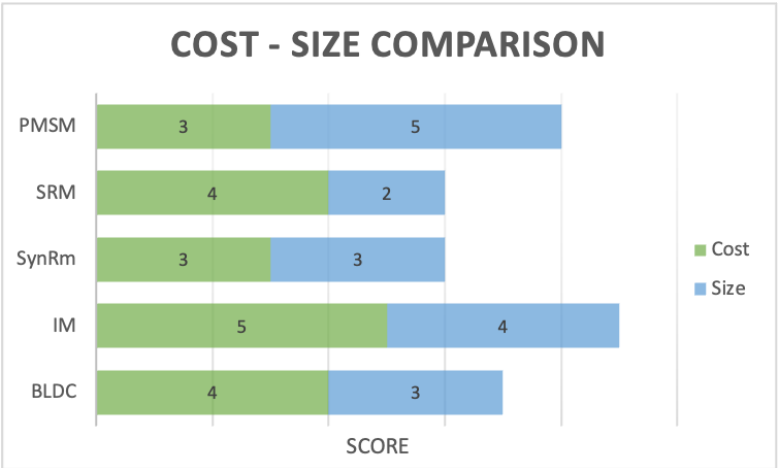
Figure 14. Direct comparison regarding cost and size parameters scoring of different motors.